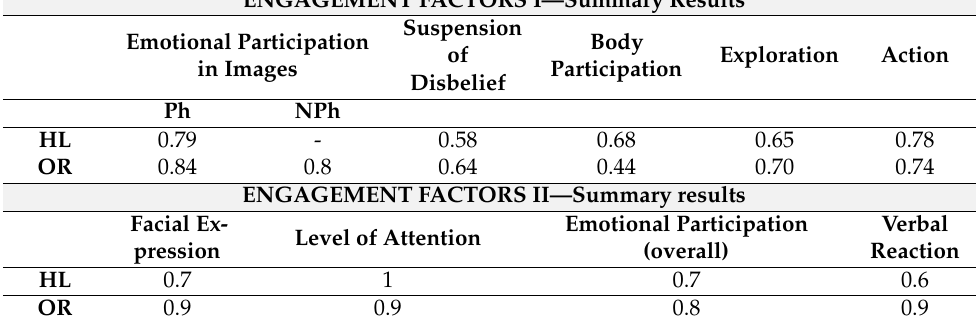
Table 9. Engagement factors—Summary